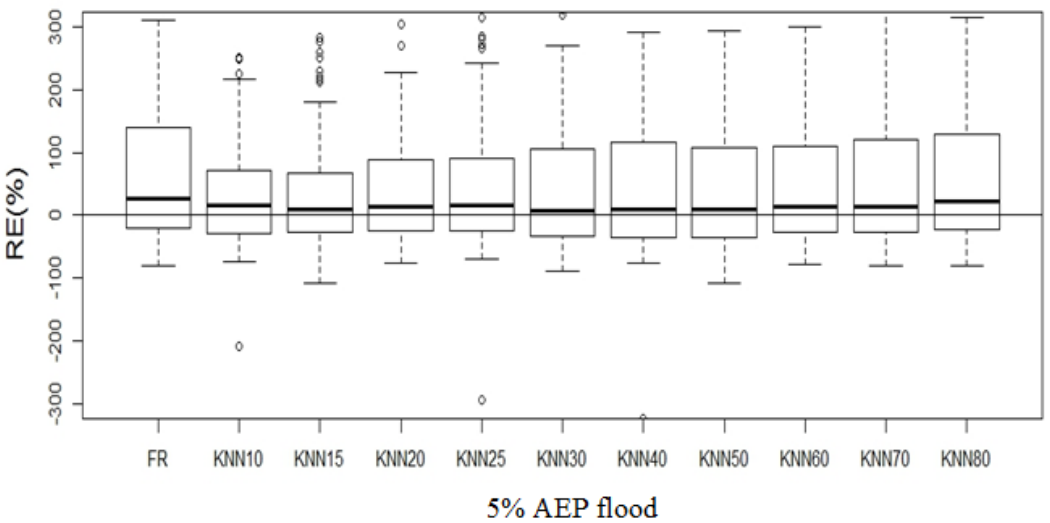
Figure 4. Boxplots for RE (%) of fixed region (FR) and ROI (in case of 5% AEP flood).